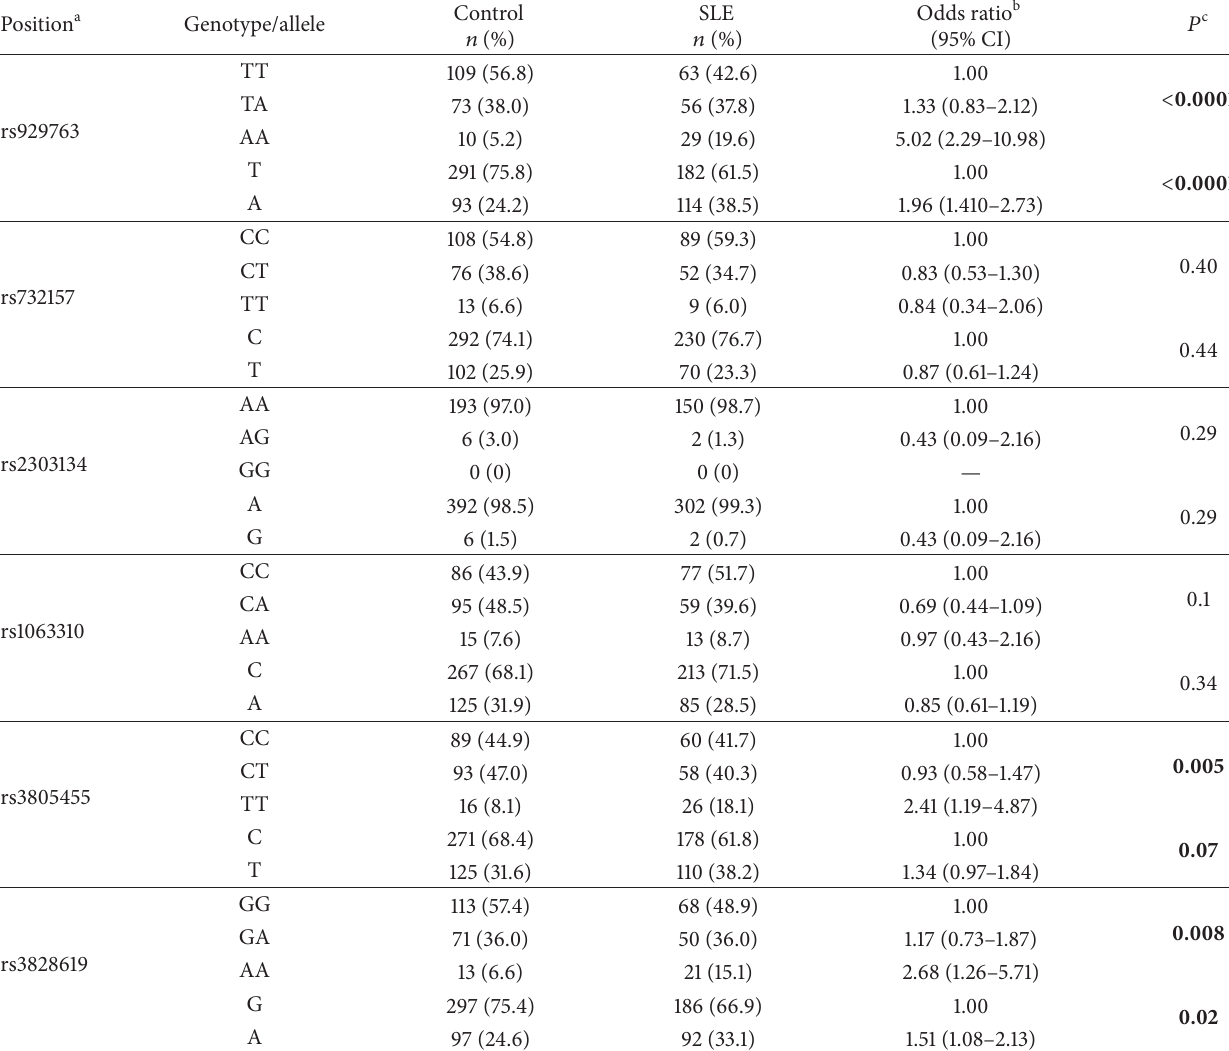
Table 3: Genotype and allele analyses of the GABRP gene polymorphisms in the female SLE patients and female healthy controls. Position a